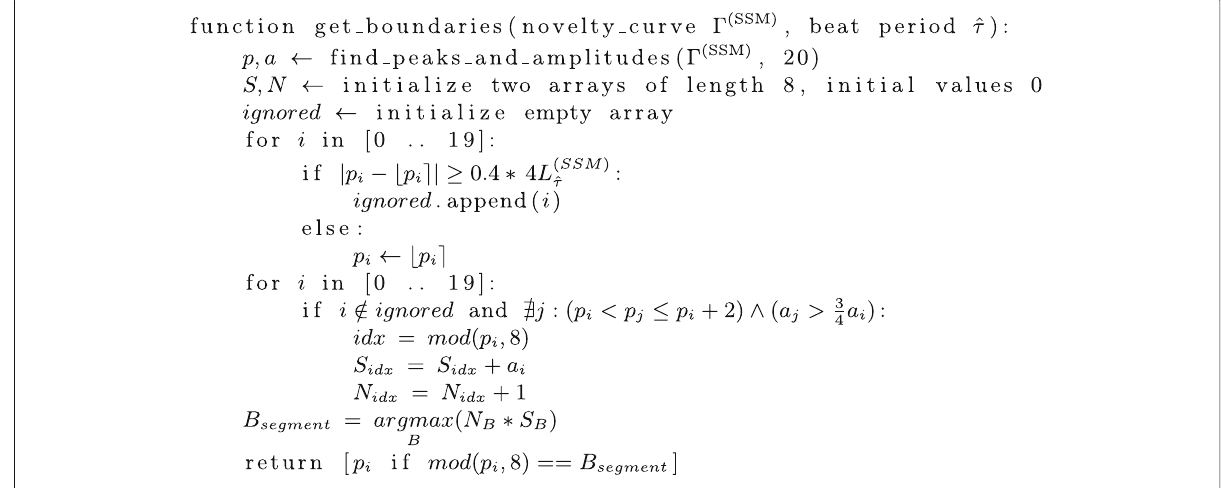
Fig. 7 Pseudo-code for selecting phrase-aligned boundaries given the SSM novelty curve in the structural segmentation